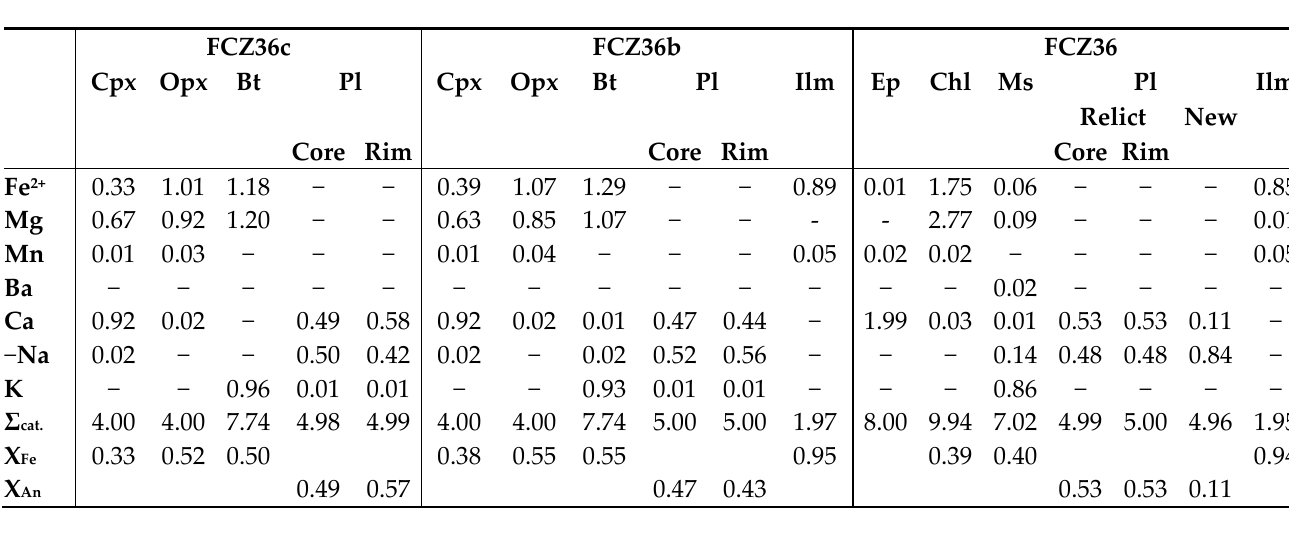
Table 4. Representative analysis of amphiboles in metabasite samples; “bdl” is an abbreviation for “below detection